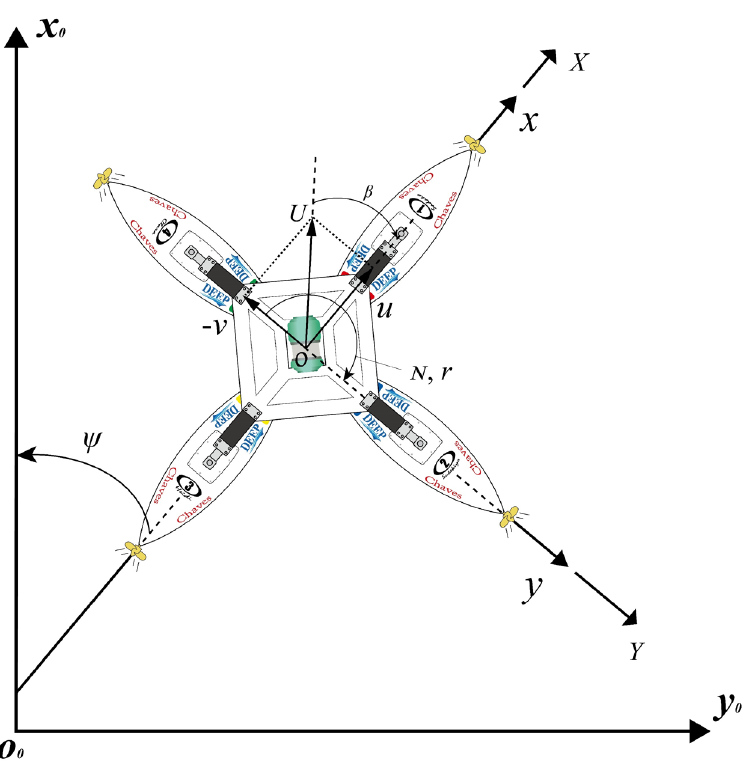
Figure 6. The coordinate system.